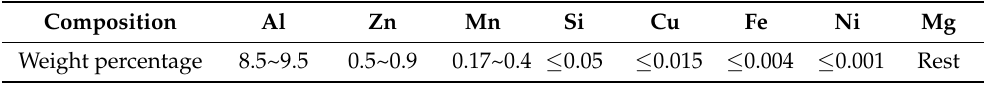
Table 1. Chemical composition of AZ91D alloy (wt